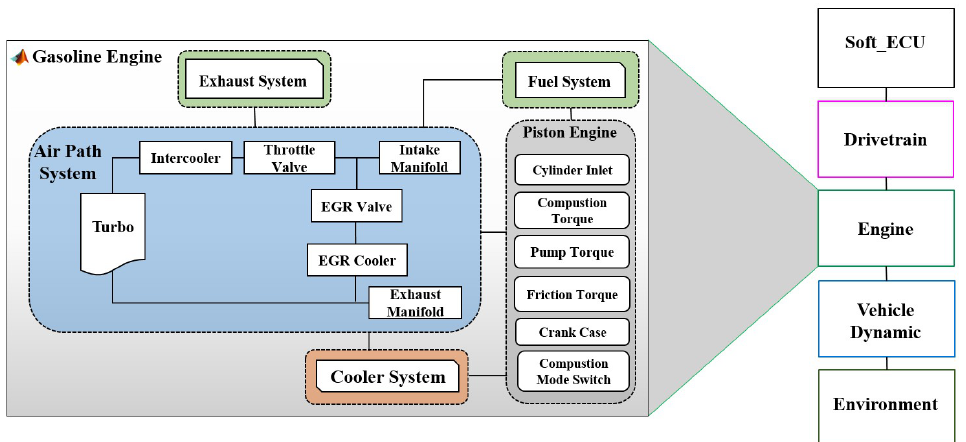
Figure 6. System architecture of the gasoline